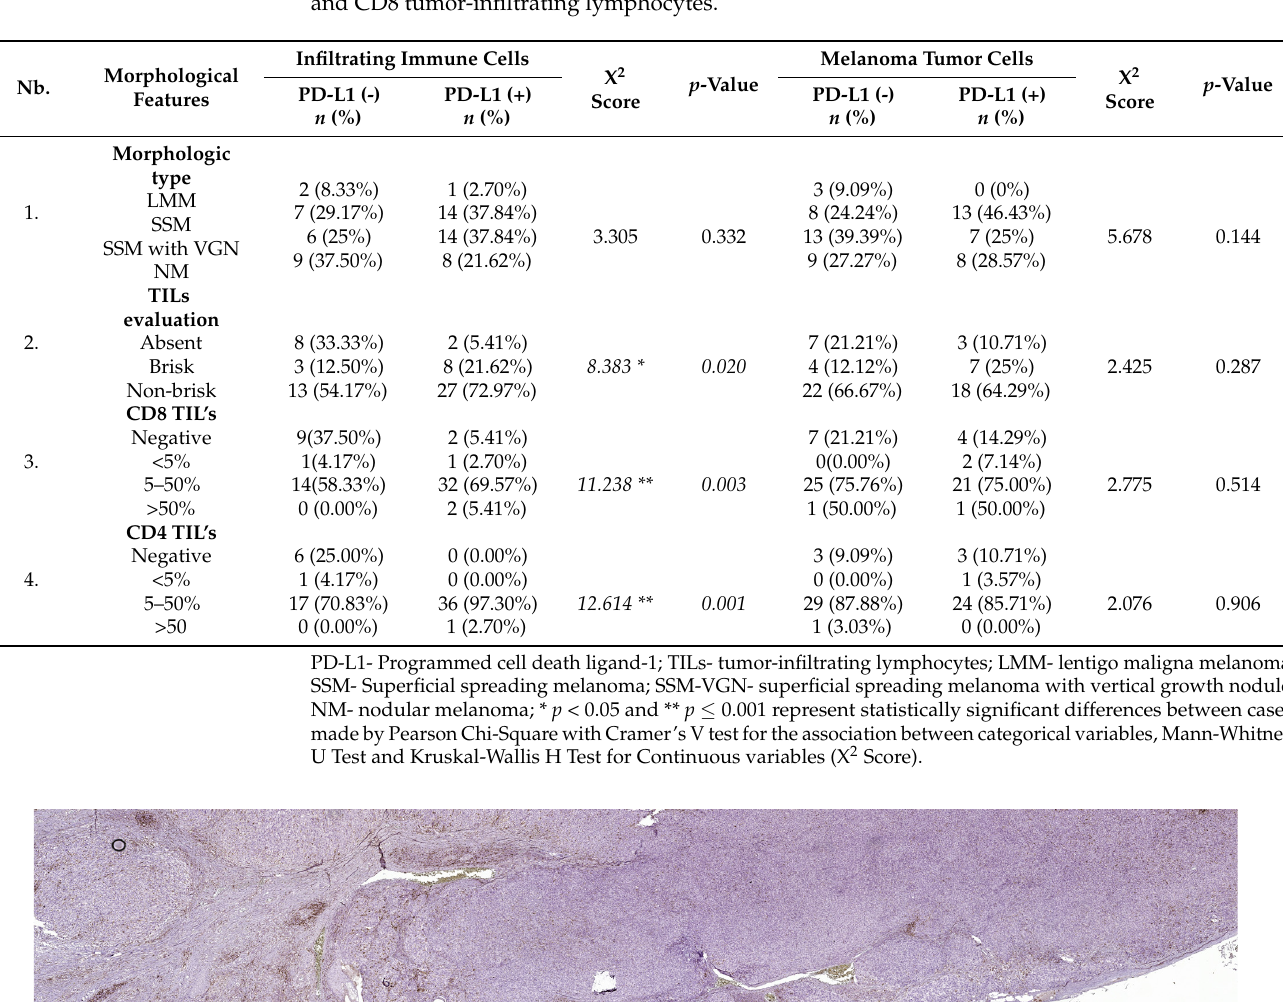
Table 2. Association between PD-L1 (+/-) expressions in tumor microenvironment cells and CD4 and CD8 tumor-infiltrating lymphocytes.